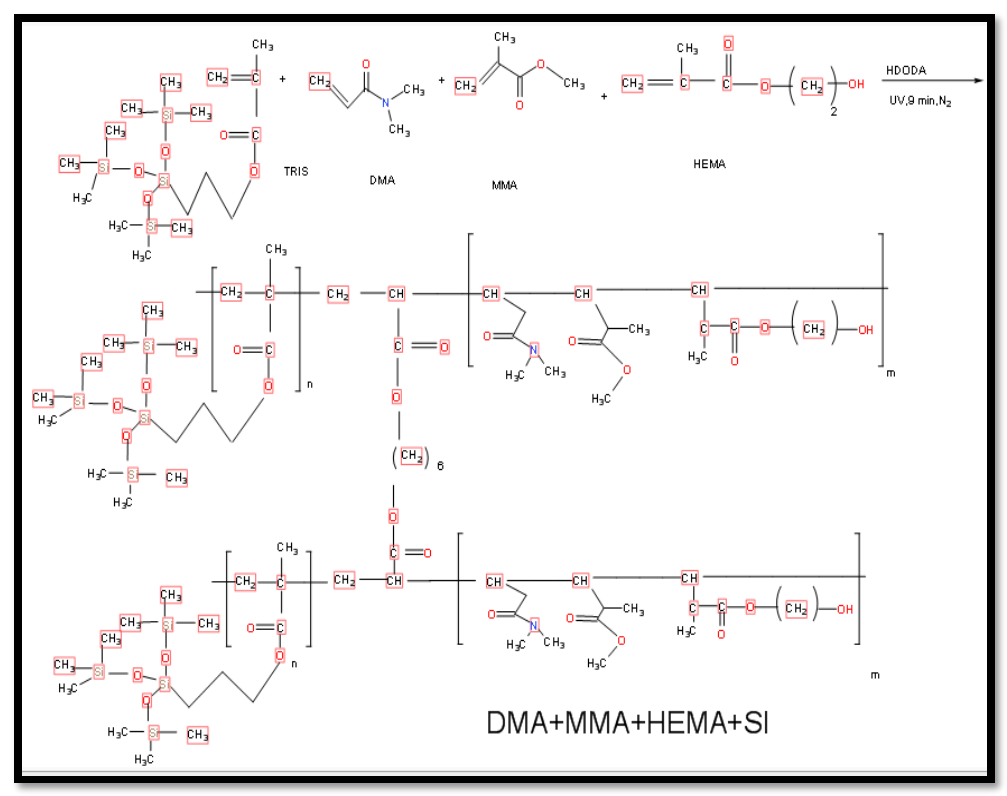
Fig. 8. Copolymerization and Crosslinking of HDODA with TRIS-co- DMA-co-MMA-co-